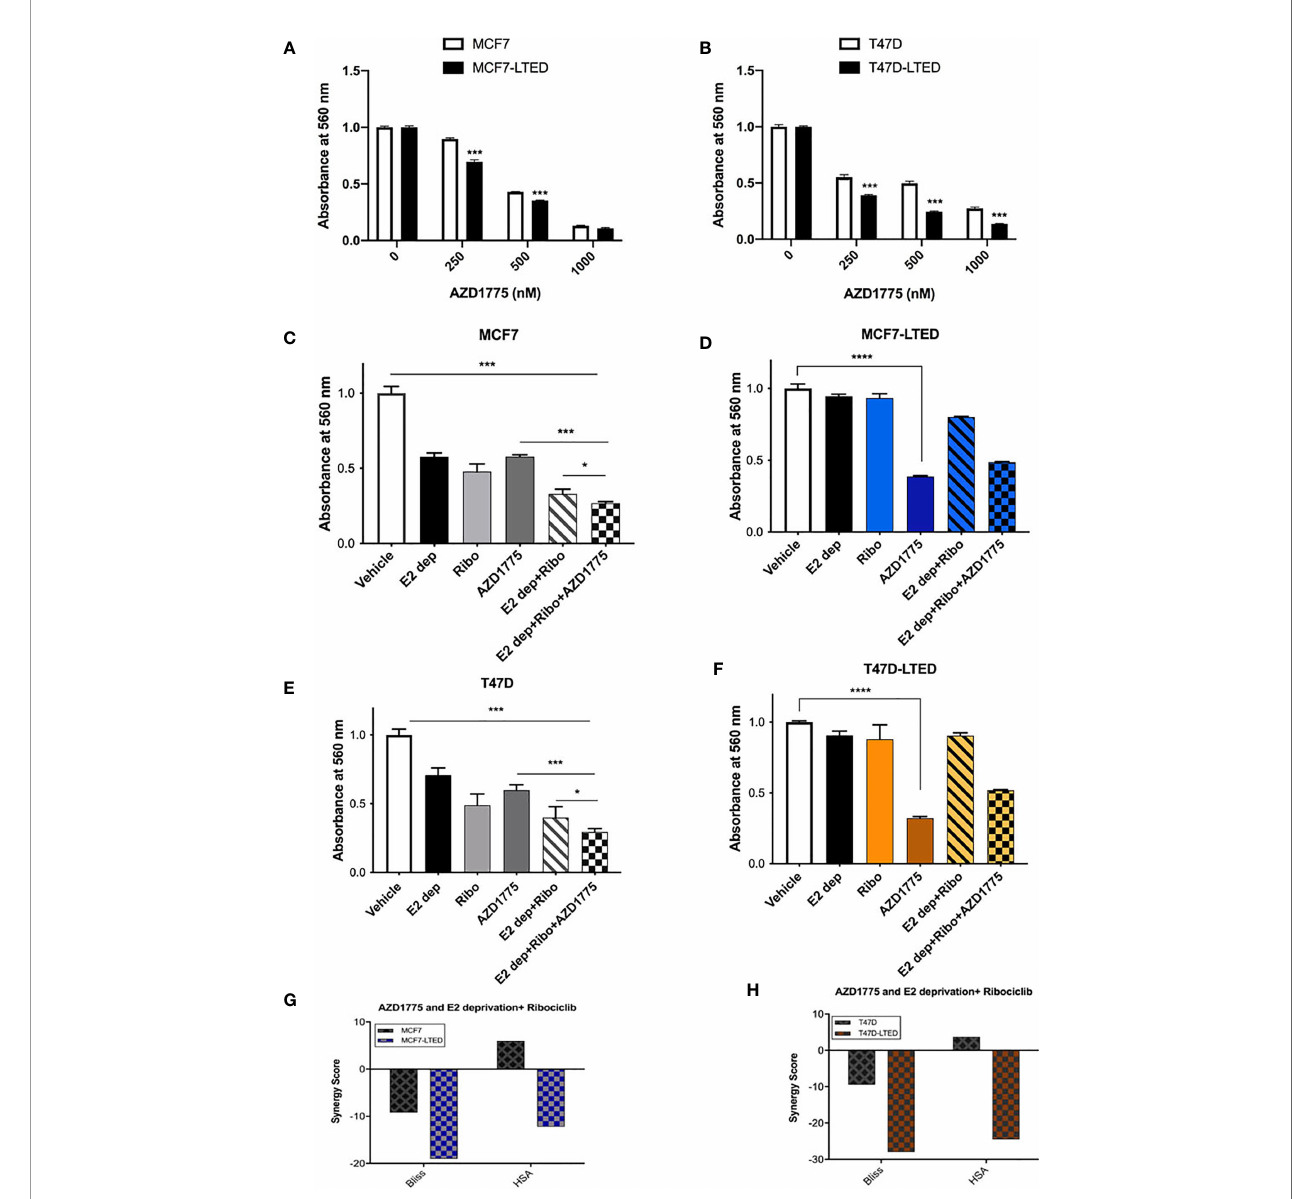
FIGURE 6 | AZD1775 monotherapy suppressed growth of LTED cells. (A, B) Parental cells (MCF7 and T47D) and LTED derivatives (MCF7-LTED and T47D-LTED) were treated with indicated concentration of AZD1775. (C – F) MCF7 and T47D cells and their LTED cells were treated with E2 deprivation (E2 dep), 500nM ribociclib (Ribo), 500nM AZD1775, combination of E2 dep and ribo or the triple combination of E2 dep, ribo and AZD1775 for 6 days. Inhibition of proliferation was measured by crystal violet assays. Data represents the average value ± SE of six replicates of relative number (normalized to vehicle alone). *p < 0.05, ***p < 0.001 and ****p < 0.0001 (ANOVA) for cell number for indicated treatment conditions compared to conditions designated by lines. (G, H) The Bliss and HSA scores using the SynergyFinder R package was used. A score >10 indicates a synergistic interaction, 10 to -10 indicates additivity and <-10 indicates antagonistic interaction between combination of E2 dep+ribo and AZD1775. All experiments were repeated at least three